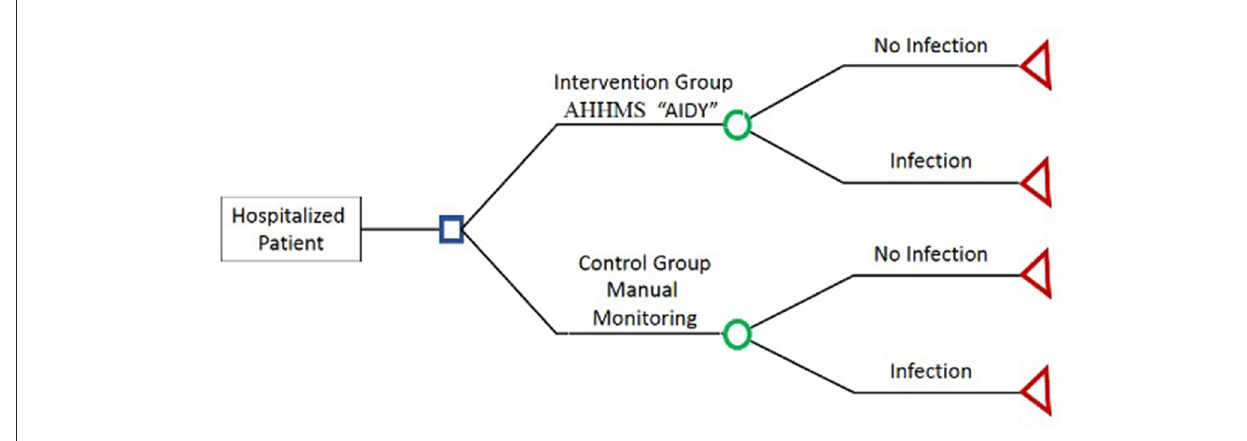
FIGURE1 Cost effectiveness decision